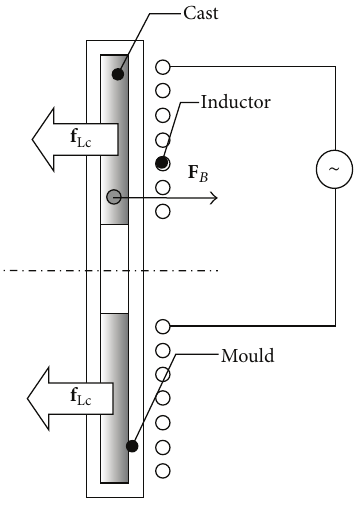
Figure 1: Diagram of the electromagnetic separation process in a one-side reinforced disc.